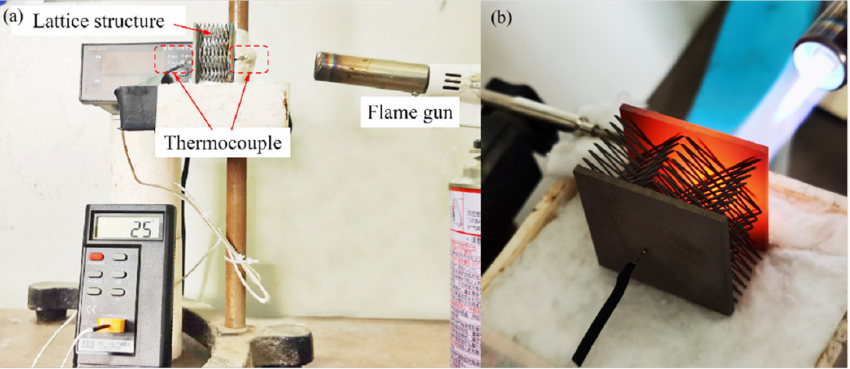
Figure 2. Measurement of thermal insulation performance for the BWR lattice: ( a ) Image of thermal insulation performance test platform; ( b ) Positions of thermocouples.